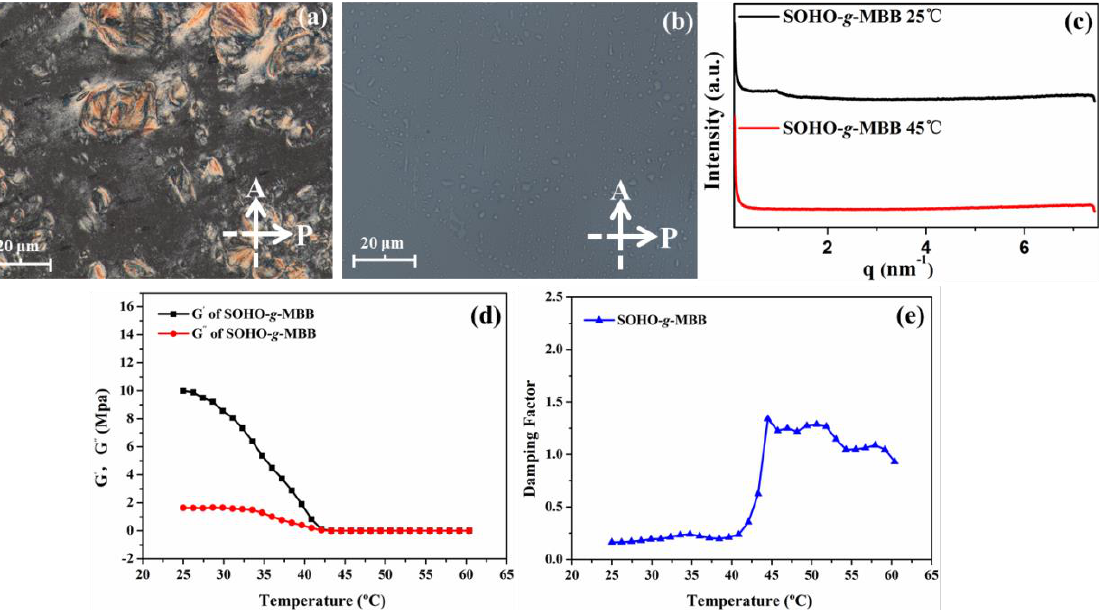
Figure 3. POM images of ( a ) SHSO- g -MBB at 25 °C and ( b ) SHSO- g -MBB at 43 °C; ( c ) SAXS curves of SHSO- g -MBB. The tests were performed at 25 °C and 43 °C. ( d ) The variations of storage (G ’ ) and loss moduli (G ’’ ) of SHSO- g -MBB with temperature and ( e ) the damping factor of SHSO- g -MBB with temperature. Table 3. The proportion of cross-linking chains, dangling chains, free chains and the cross-linking density of all the LCMVPQs and